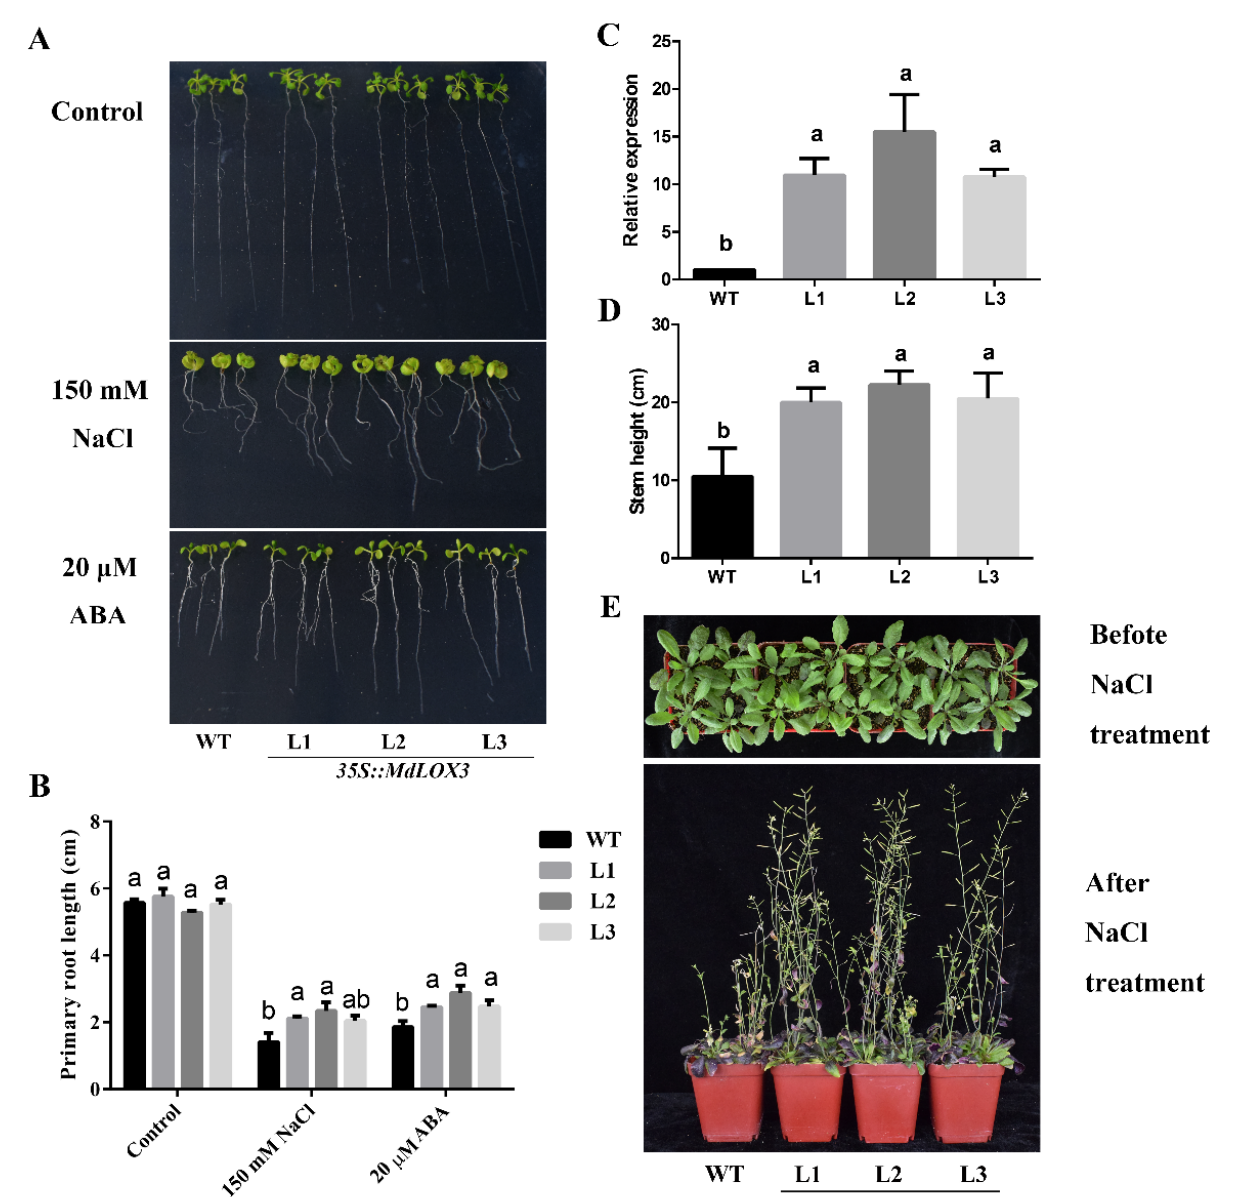
Figure 5. Ectopic expression of MdLOX3 positively regulates resistance to salt and ABA. ( A ) Growth phenotypes of WT and transgenic Arabidopsis treated with nothing added or supplemented with NaCl (150 mM) or ABA (20 μM). ( B ) Analysis of primary root length in WT and transgenic Arabidopsis shown in ( A ). ( C ) Expression analysis of MdLOX3 in WT and the transgenic Arabidopsis . ( D ) Analysis of stem height in WT and transgenic Arabidopsis shown in ( E ). ( E ) Phenotypes of Arabidopsis treated with 150 mM of NaCl after 21 days. Error bars, ± SD of three independent replicates. Different lowercase letters represent significant differences ( p <